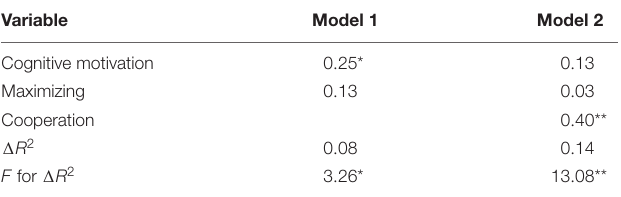
TABLE 2 | Results of regression analyses.